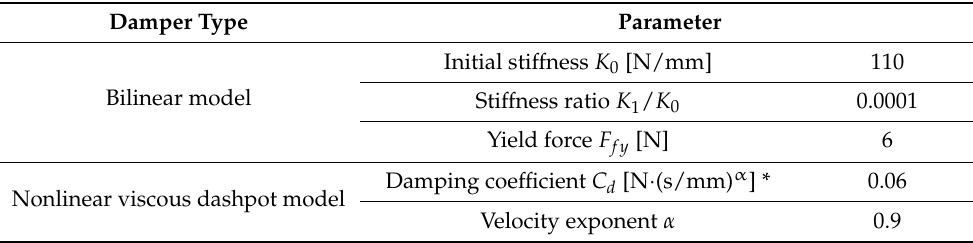
Figure 22. Restoring force characteristics of damper in the simulation model. Table 5. Damper parameter in the analytical model.